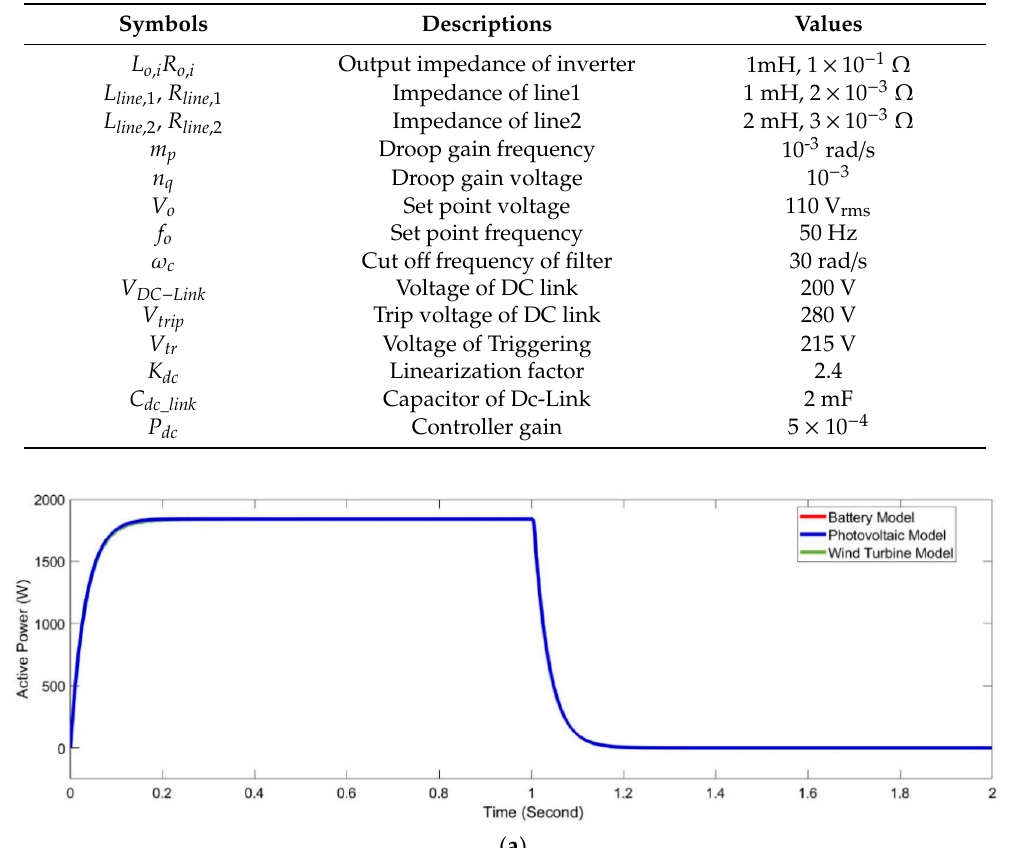
Table 7. The parameters of the system.